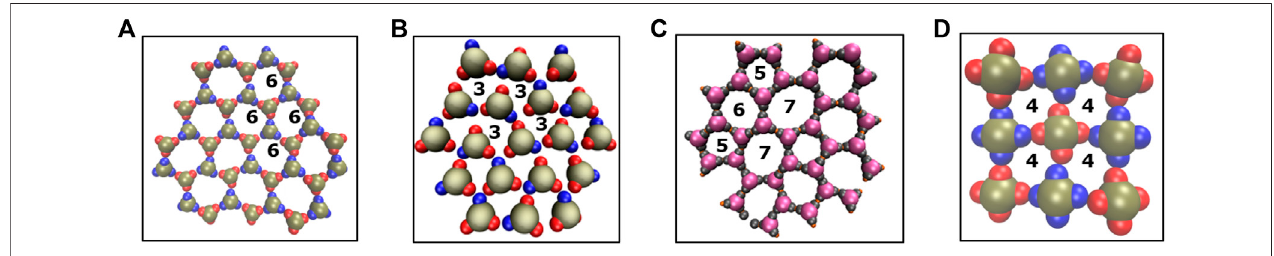
FIGURE 5 | A comparison of structural motifs in sheet-like morphologies reported in this study and our previous work [18, 27]. (A – C) Ring-like arrangements of particleswiththreelobesare shown:sixmembered rings(panelA,currentwork), threememberedrings (panel B,previous work[27]), and fi ve orsevenmemberedrings (panel C, previous work [18]). (D) Four membered rings formed by the square planar ( S SP 4 ) particles from our current work.